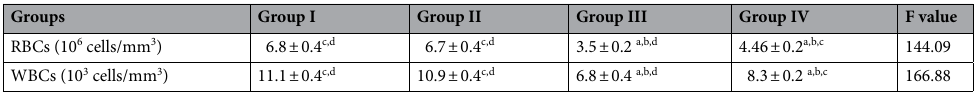
Table 3. Effect of FUC on hematological parameters (RBCs and WBCs) counts among the studied groups. Data are represented as mean ± SD. Statistical analysis was carried out using one-way ANOVA with Tukey’s post hoc test, SPSS computer program. a–d Significant difference between groups at * p < 0.05. a Significance from group I; b significance from group II; c significance from group III; d significance from group IV. Degree of freedom is (3) between groups and (24) within groups (total = 27). RBCs Red blood cells, WBCs White blood